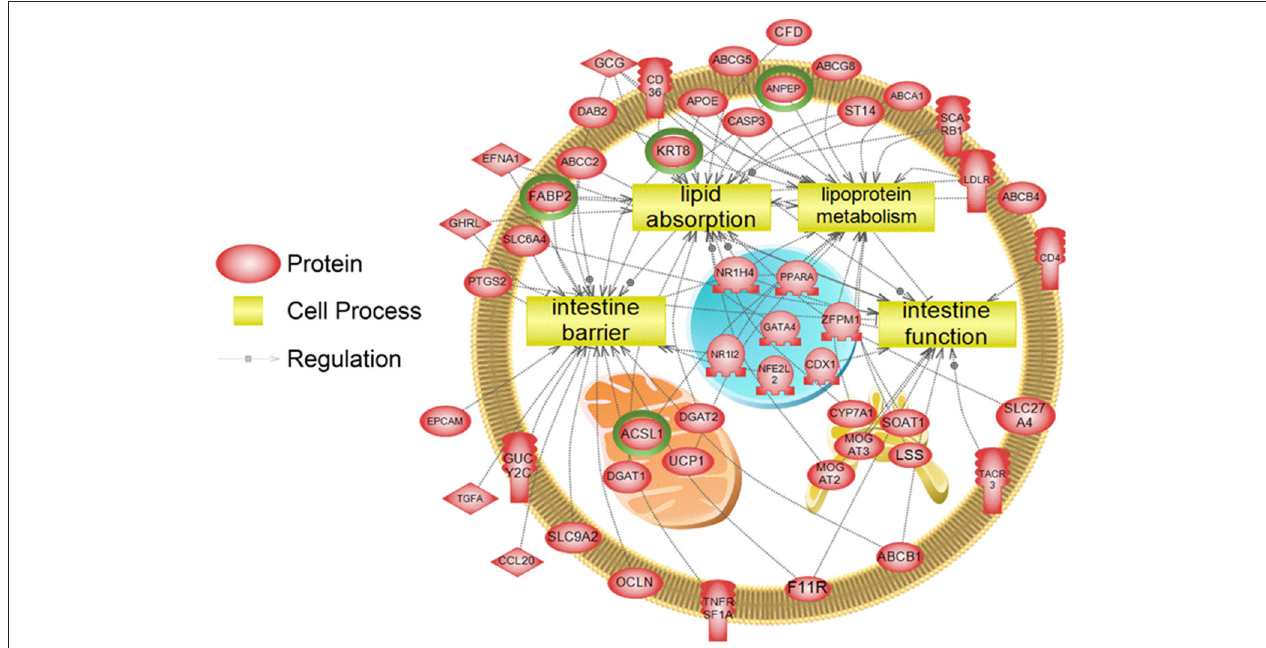
FIGURE 8 | Subnetwork enrichment analysis of the transcriptome for the gut. The figure represents the joining of 4 top pathways identified by the analysis. Genes encircled in green were also found to be enriched in the gut in the proteomics experiment. ABCA1, ATP-binding cassette, sub-family A (ABC1), member 1; ABCB1, ATP-binding cassette, sub-family B (MDR/TAP), member 1; ABCB4, ATP-binding cassette, sub-family B (MDR/TAP), member 4; ABCC2, ATP-binding cassette, sub-family C (CFTR/MRP), member 2; ABCG5, ATP-binding cassette, sub-family G (WHITE), member 5; ABCG8, ATP-binding cassette, sub-family G (WHITE), member 8; ACSL1, acyl-CoA synthetase long-chain family member 1; ANPEP, alanyl (membrane) aminopeptidase; APOE, apolipoprotein E; CASP3, caspase 3, apoptosis-related cysteine peptidase; CCL20, chemokine (C-C motif) ligand 20; CD36, CD36 molecule (thrombospondin receptor); CD4, CD4 molecule;